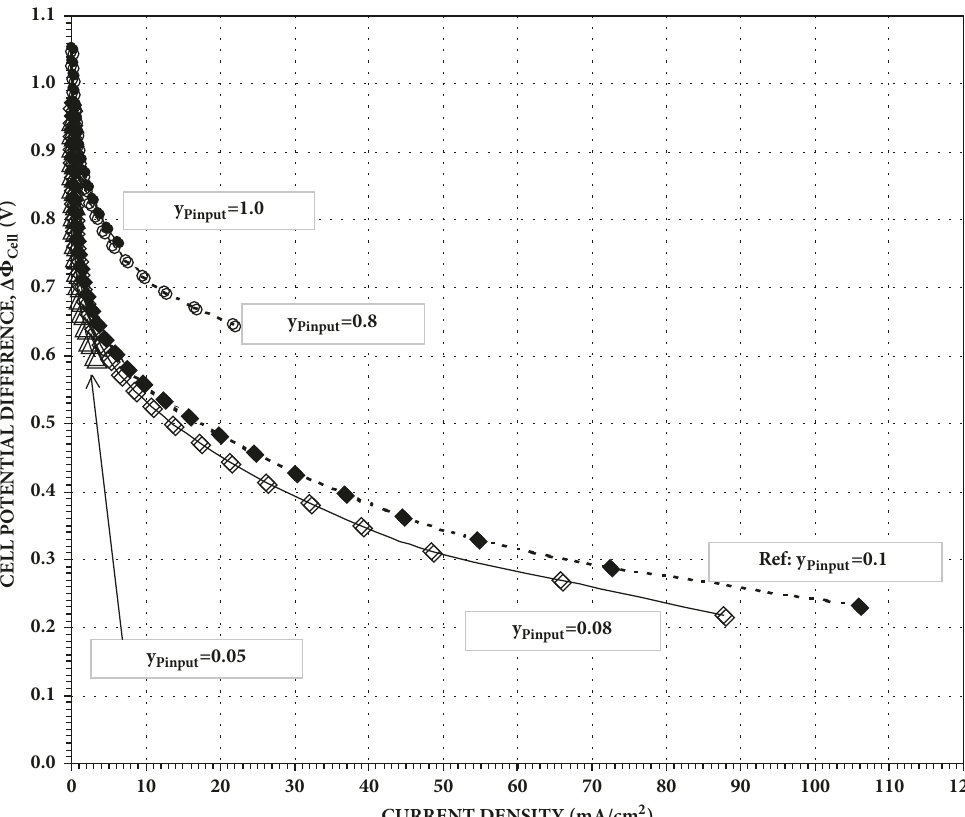
Figure 10: The effect of the propane inlet mole fraction, y , on the polarization curvefor a direct propane fuel cell (DPFC) model at 150 ∘ C Pinput and 1 atm. The values of y for the above five cases were represented by the following symbols: (i) solid circles: 1, (ii) open circles: 0.8, (iii) Pinput solid diamonds: 0.1 (reference case), (iv) open diamonds: 0.08, and (v) open triangles: 0.05. All the other parameters were the same as the reference case mentioned in Table